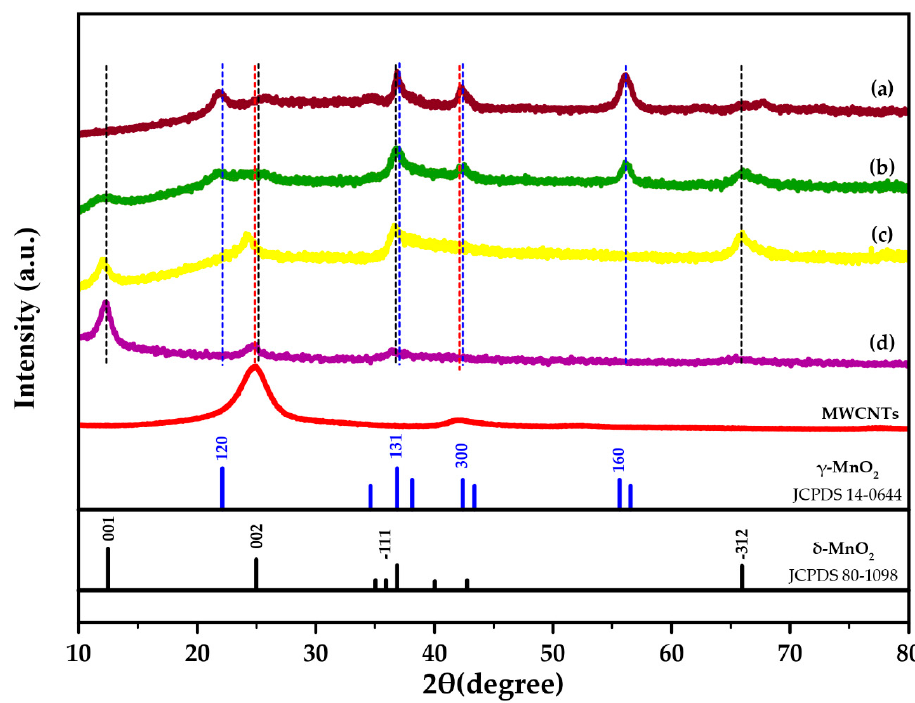
Figure 1. X-ray Diffraction (XRD) patterns of multi-walled carbon nanotubes (MWCNTs) and synthesized MnO 2 on multi-walled carbon nanotubes (MN-CNT) with different ratios of MnO 2 :MWCNTs: ( a ) 60:40-MN-CNT6040 ( b ) 75:25-MN-CNT7525 ( c ) 90:10-MN-CNT9010 and ( d ) synthesized δ -MnO 2 .